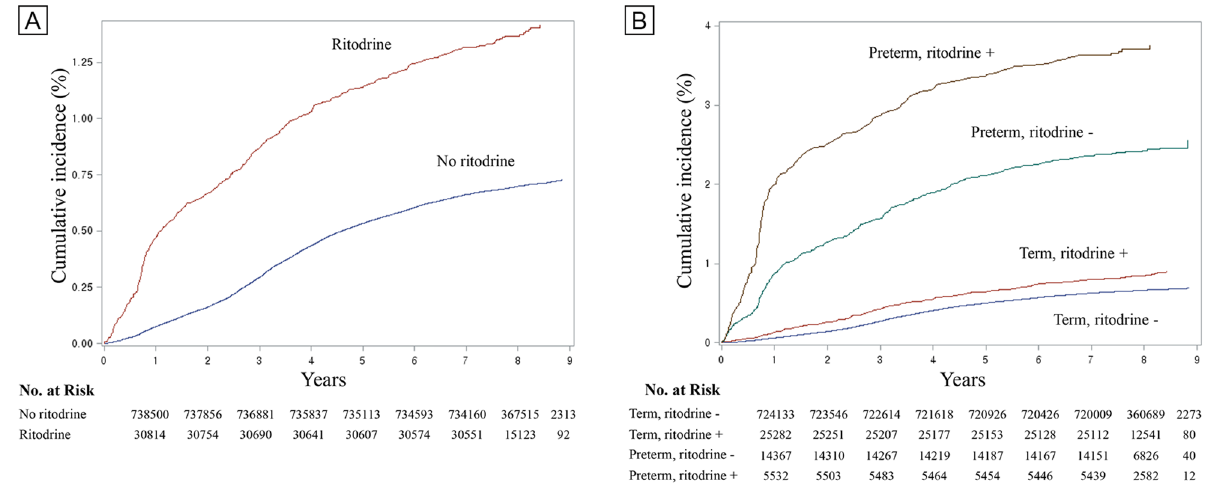
Figure 2. ( A ) Cumulative incidence of autism up to 8 years of age depending on ritodrine exposure. ( B ) Subgroup analysis; cumulative incidence of autism up to 8 years of age by preterm and term birth on ritodrine use.